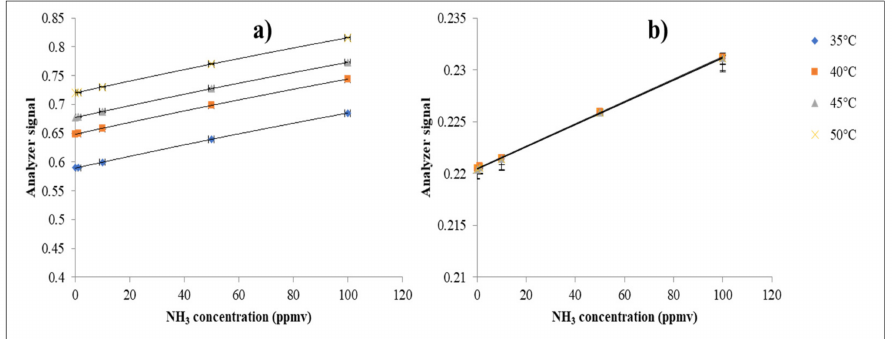
Figure 9. Aging effects of the detector through its various temperatures influencing the zero-drift of calibration curves of the NDIR analyzer coupled with the typical reference method ( a ) and the feasible method ( b